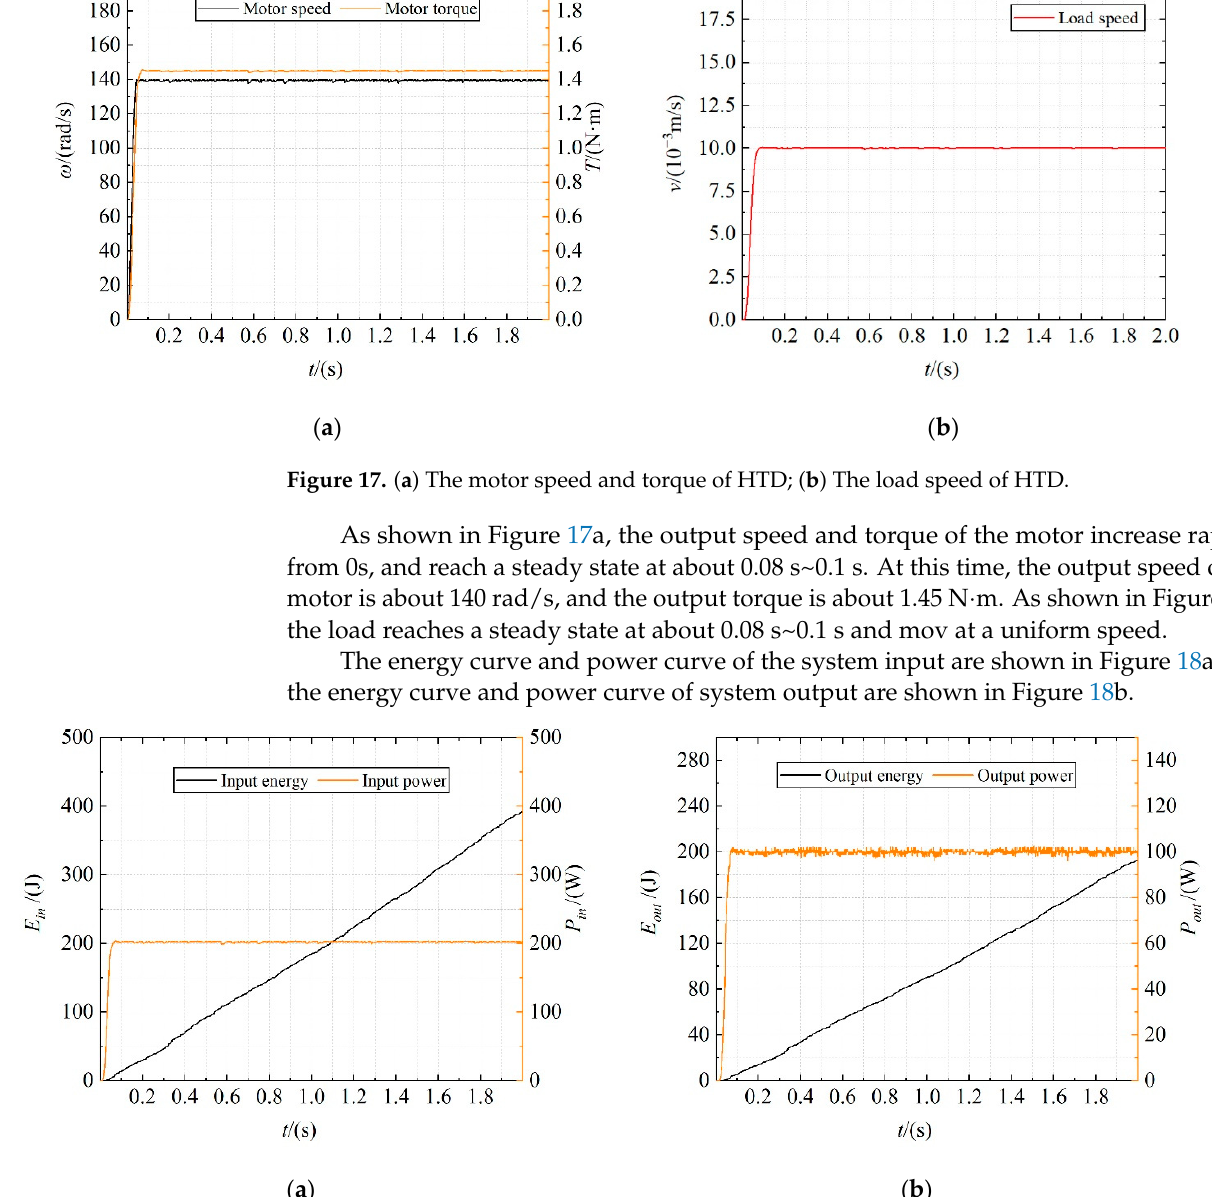
Torque Gain PI Figure 16. Mathematical model of the motor.